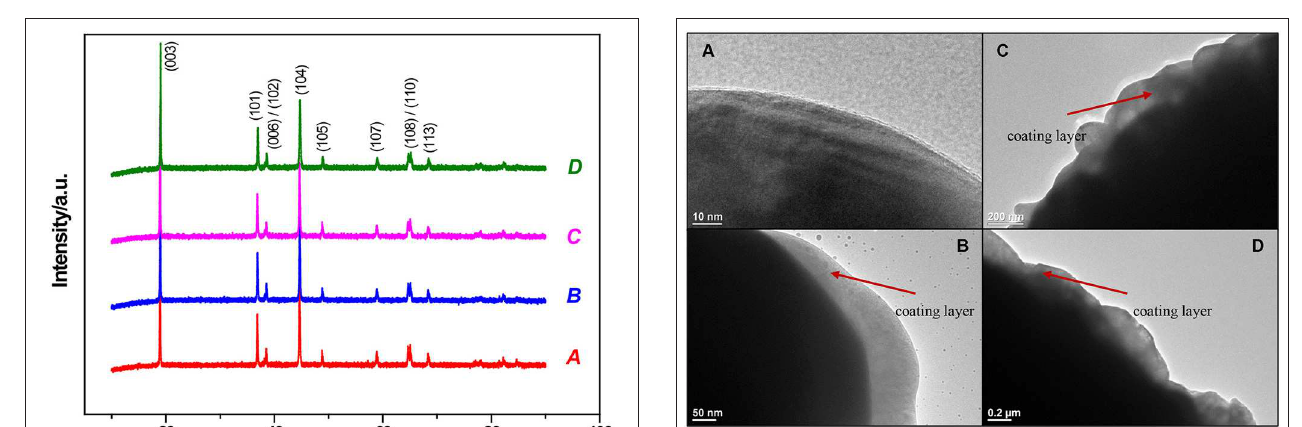
Figure 4C is a TEM image of the NCM811 coated with ZrO 2 .